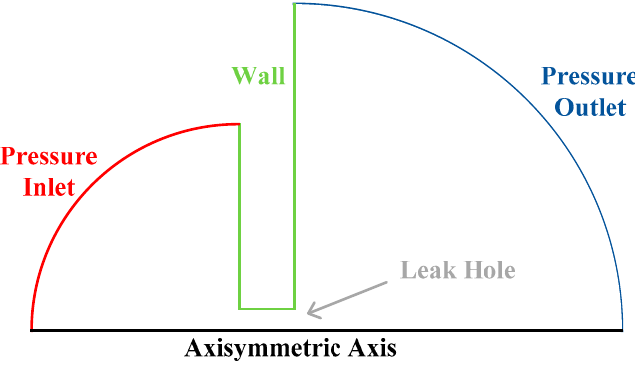
Figure 1. Schematic diagram of the computational model.